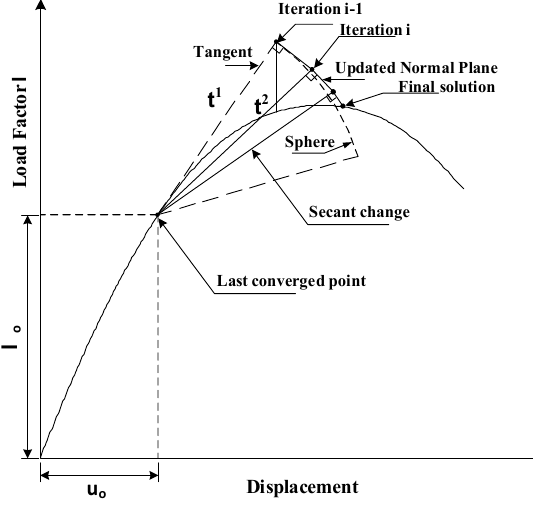
Fig. 6. Updated normal plane method “Ramm Method” (Ramm (1980,